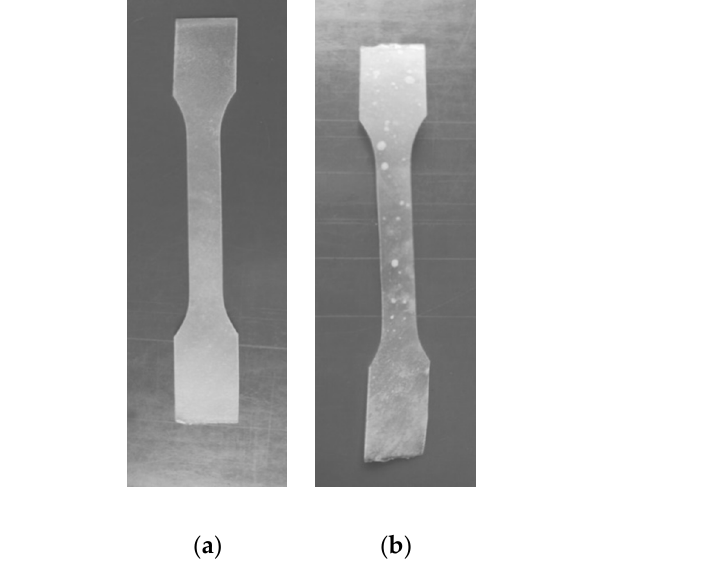
Figure 5. Photographs of PLA–PHB composition films (80: 20 wt % + 10 wt % PEG 400 ) before ( a ) and after ( b ) exposure in soil within 3 months.